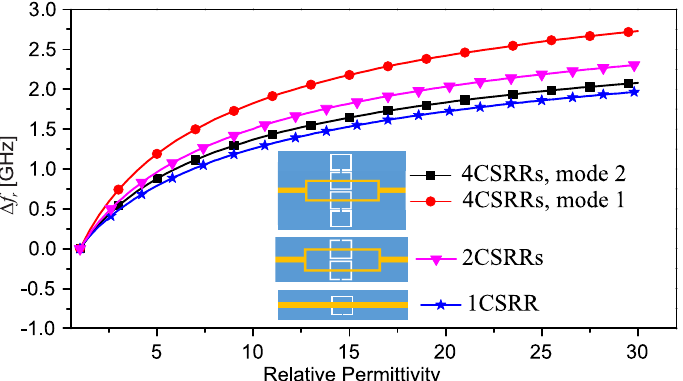
Figure 9. Resonance frequency shifts versus the dielectric constant of the slab that is varied from 1 to 30 with a step size of 0.2. Reprinted with permission from Ref.